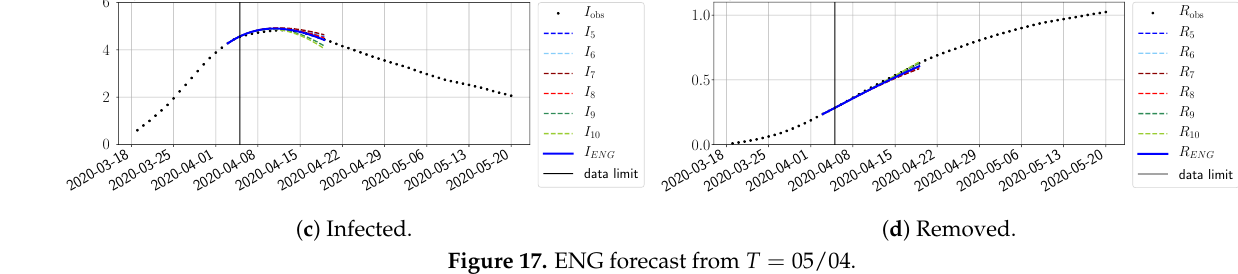
Figure 17. ENG forecast from T = 05/04.